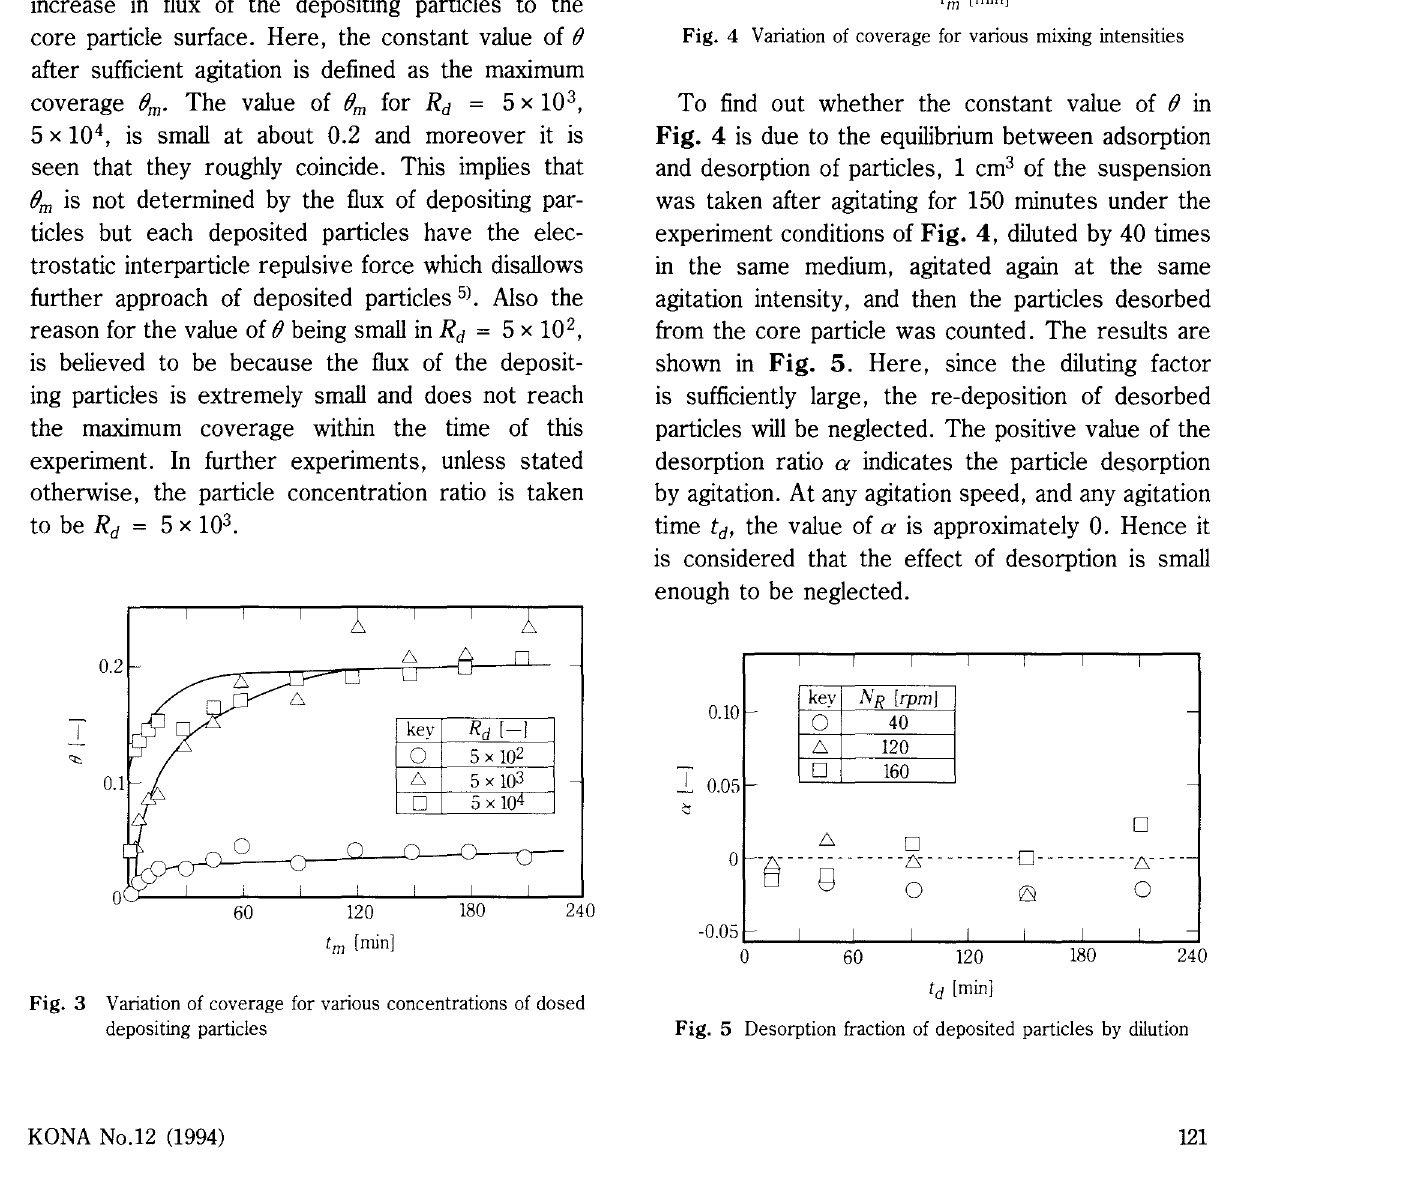
KONA No.12 (1994)